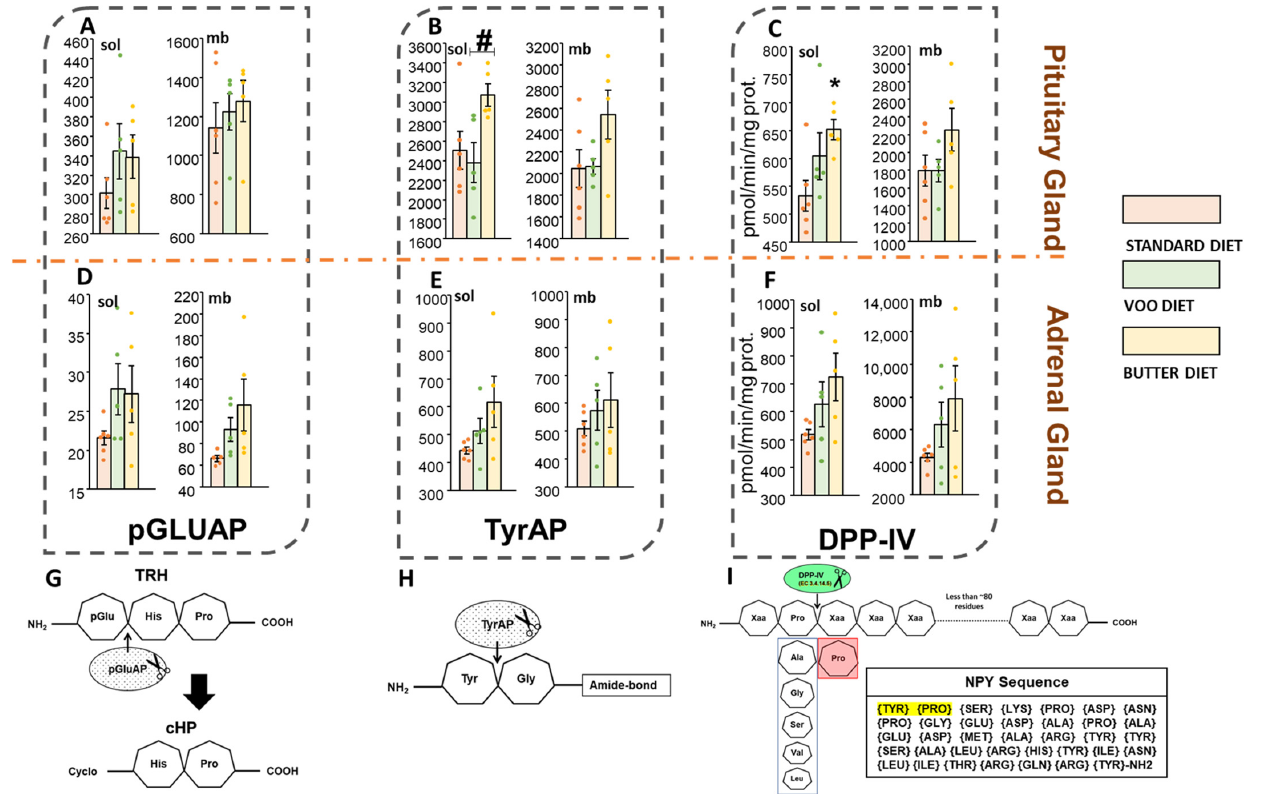
Figure 4. Metabolism of Dipeptidyl peptidase IV (DPP-IV), pyroglutamyl-aminopeptidase (pGluAP) and tyrosyl-aminopeptidase (TyrAP) activities. ( G ) Schematic of the metabolic conversion of thyrotropin-releasing hormone (TRH) to histidyl-proline diketopiperazine (cyclo [His-Pro]; CHP) by hydrolytic action of pGluAP activity. ( A , D ) pGluAP (sol and mb) activity of the pituitary and adrenal glands. ( H ) Schematic representation of TyrAP activity, which cleaves the Tyr-Gly amide-bond. ( B , E ) TyrAP (sol and mb) activity of the pituitary and adrenal glands. ( I ) Schematic representation of DPP-IV activity, that cleaves on the carboxy terminal (C-terminal) side of the proline residue. DPP-IV liberates a dipeptide from its substrates (below 80–100 residues) with proline (Pro) or alanine (Ala) at the second amino (NH2)-terminal position. It is remarked other preferred substrates, but with a slower cleavage rate depending on the residue that forms the second NH2-terminal position. DPP-IV cannot cleave substrates if the third residue is proline. The complete sequence of neuropep- tide Y (NPY) appears in the inset, with a red arrowhead indicating the site of hydrolysis of DPP-IV. ( C , F ) DPP-IV activity in the soluble (sol) and membrane-bound (mb) fractions of the pituitary and adrenal glands. S: standard diet; VOO: diet enriched with virgin olive oil; Bch: diet enriched with butter and cholesterol. The activities were expressed as picomoles of β -naphthylamide per minute per milligram of protein (pmol/min/mg prot.). * p -value < 0.05, compared to standard diet (S). # p -value < 0.05, compared between HFDs (VOO vs.